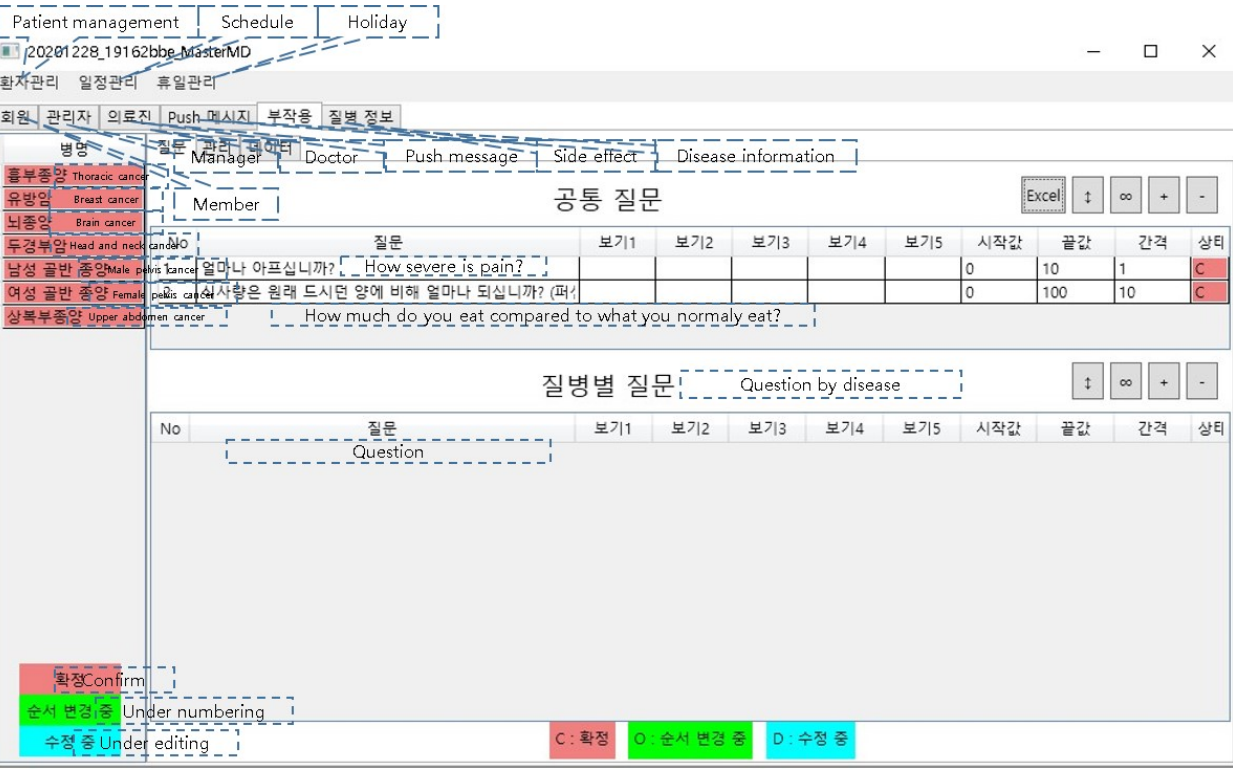
Figure 5. Side effect questionnaire window